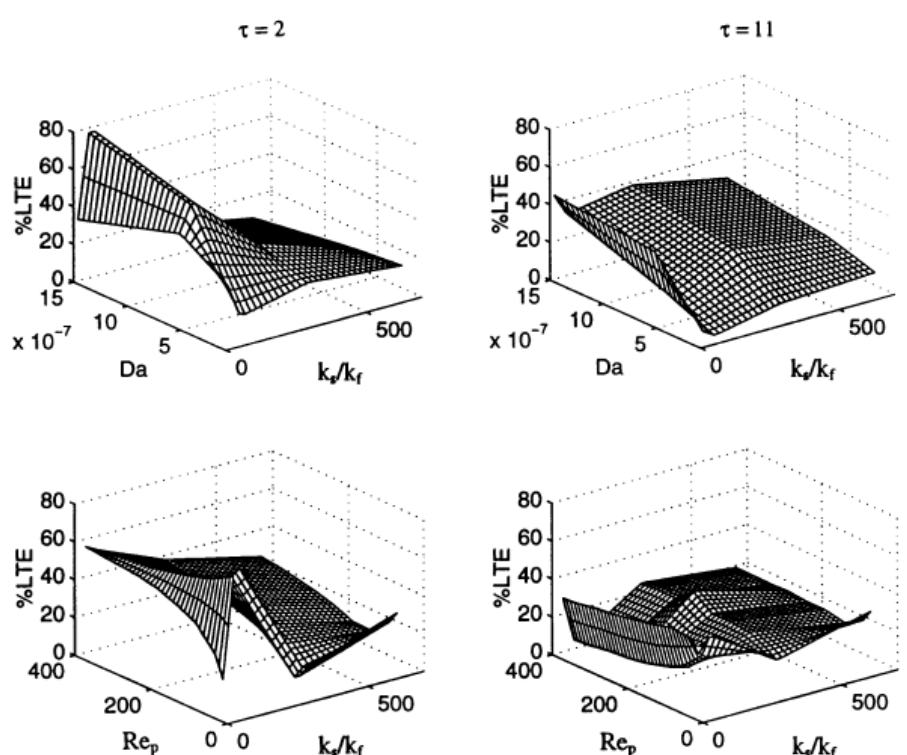
Figure 16. Instant assessment of the legality of LTE condition for different Darcy number, Reynolds number, and thermal conductivity ratio for two times ( τ = 2,11), reported by Amiri and Vafai [43].